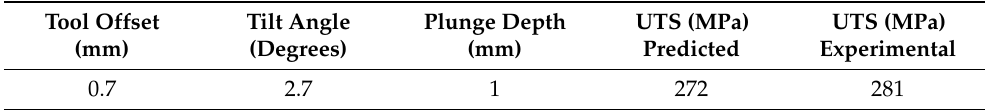
Table 8. The statistical and experimental UTS magnitudes of optimized